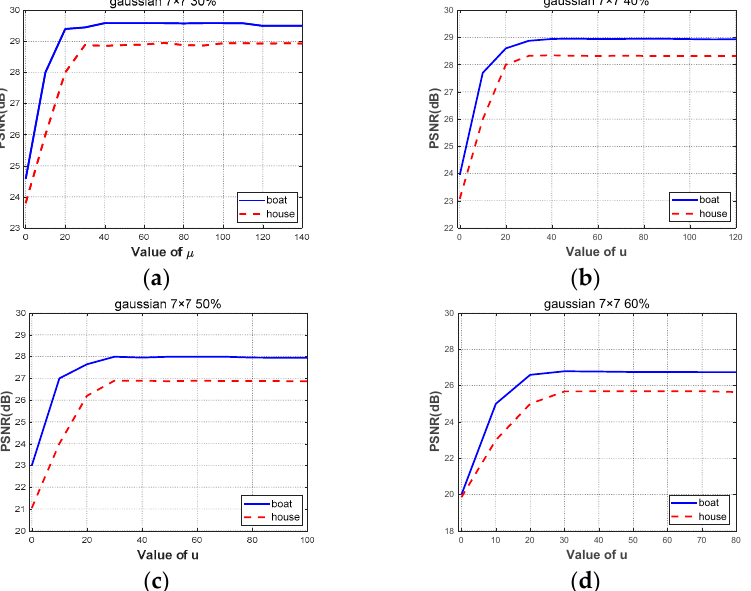
μ Figure 6. Effects of regularization parameter µ on experimental results ( a–d ) refer to effect of µ on Figure 6. Effects of regularization parameter on experimental results ( a–d ) refer to effect of on PSNR at noise levels of 30%, 40%, 50%, and 60%, respectively. PSNR at noise levels of 30%, 40%, 50%, and 60%, respectively.